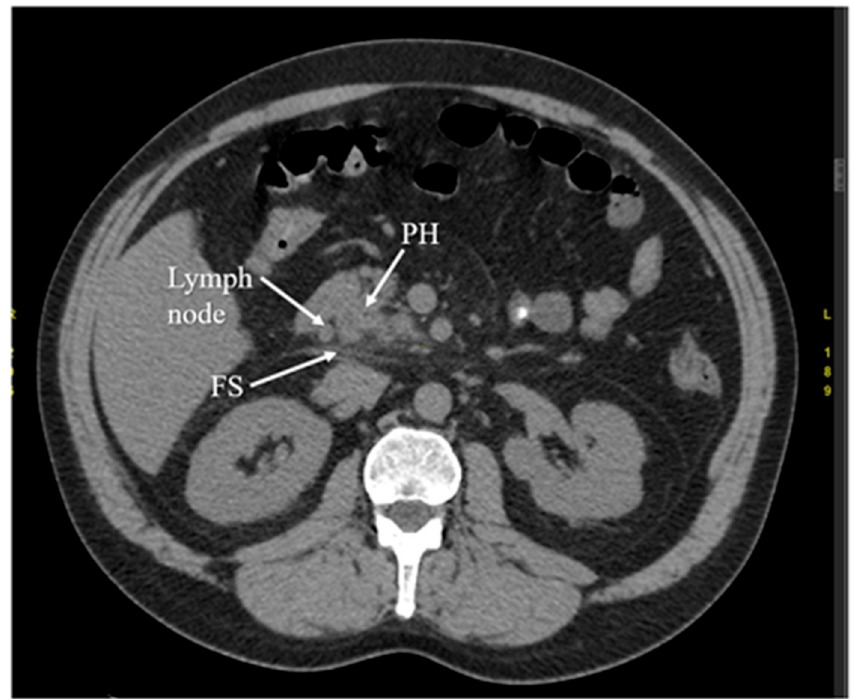
Figure 3. Early phase of the acute pancreatitis with stranding of surrounding fat (FS) and single, enlarged lymph node. The arterial phase of CT. PH—head of the pancreas.